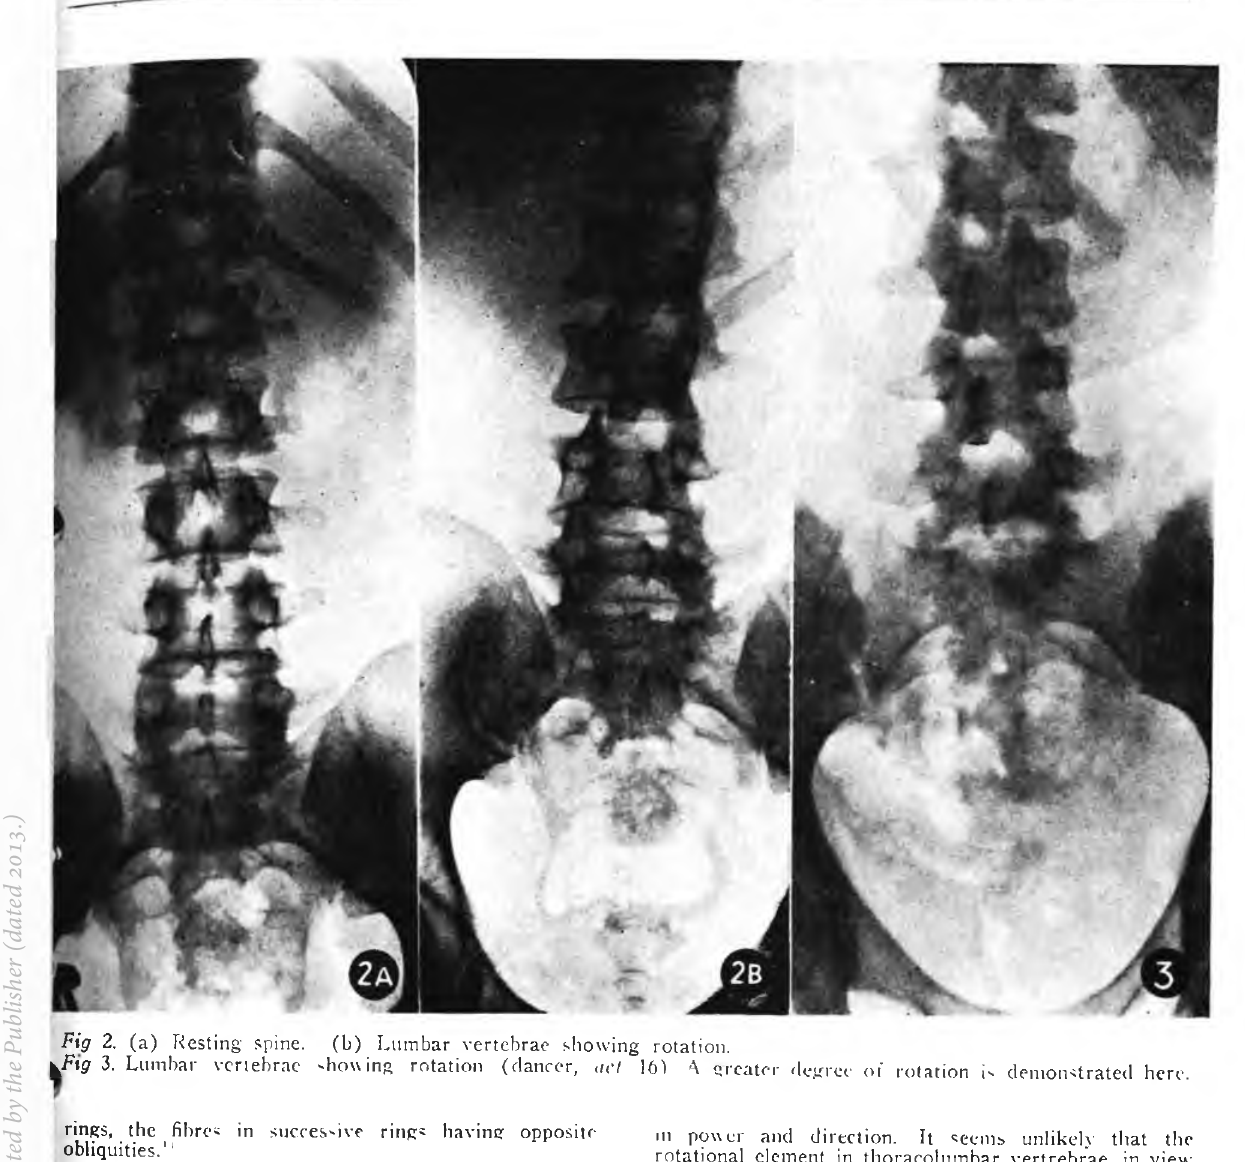
rings, the fibres in successive rings havinc: opposite